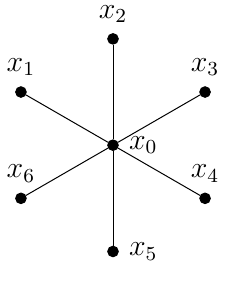
Figure 1: A star G [ X